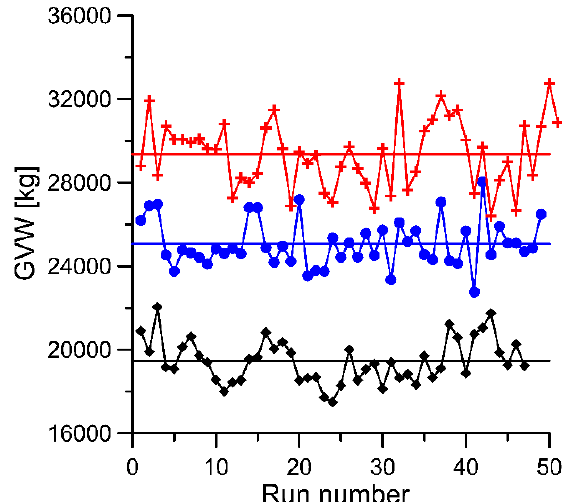
Figure 4. GVW for three reference vehicles in successive runs (as a sum of axle load from the WIM system). black—vehicle no. 1; blue—vehicle no. 2; red—vehicle no. 3 (see Table 1).